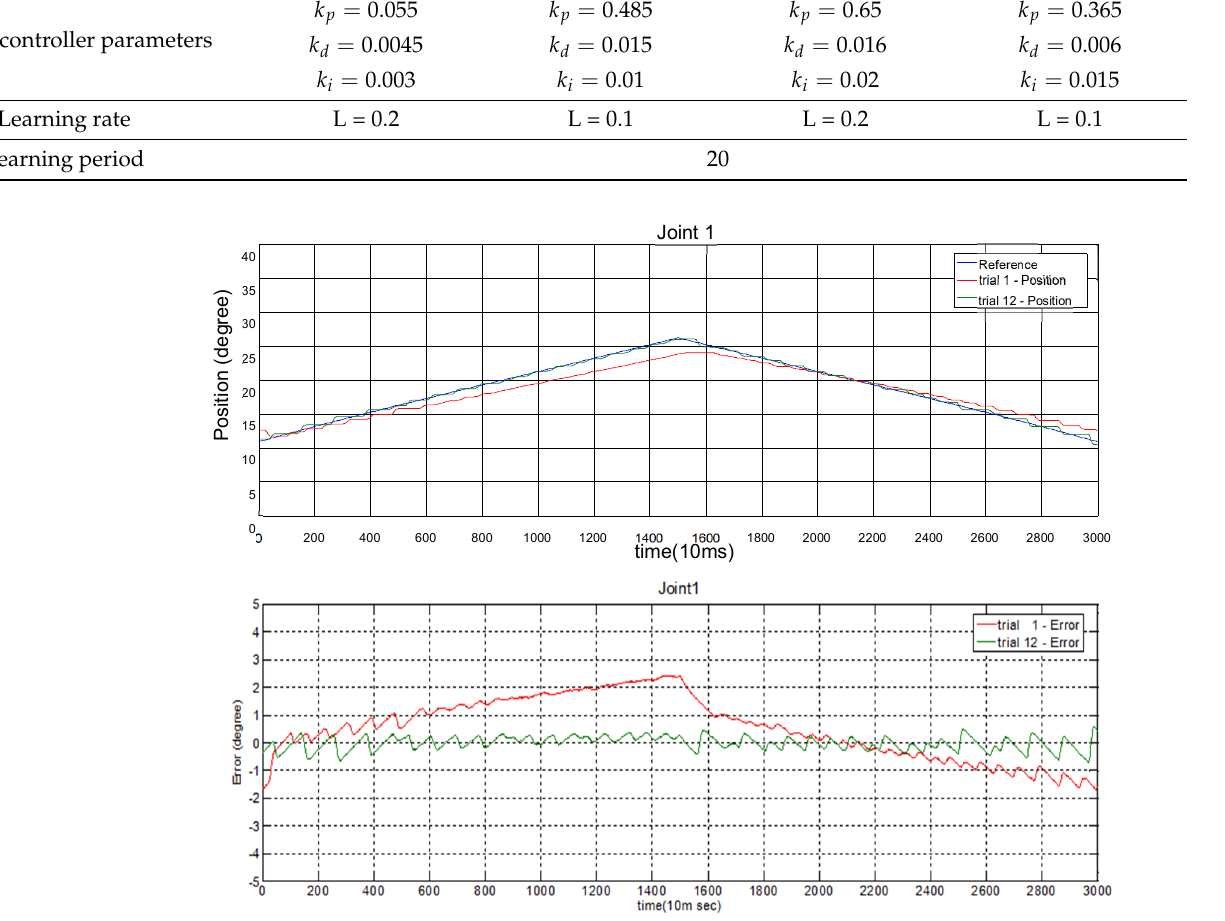
Figure 23. Trajectory 1—1st-axis (load-on) ILC trial 1 and trial 12 tracking and error diagrams.